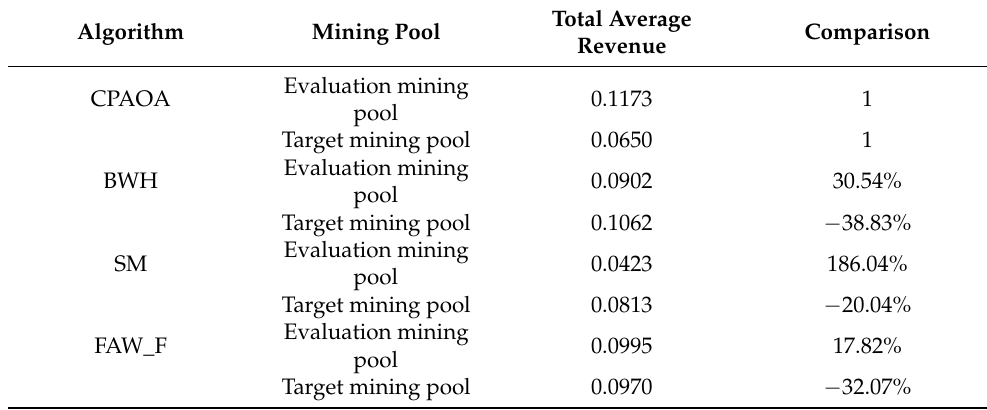
Table 2. Experimental summary